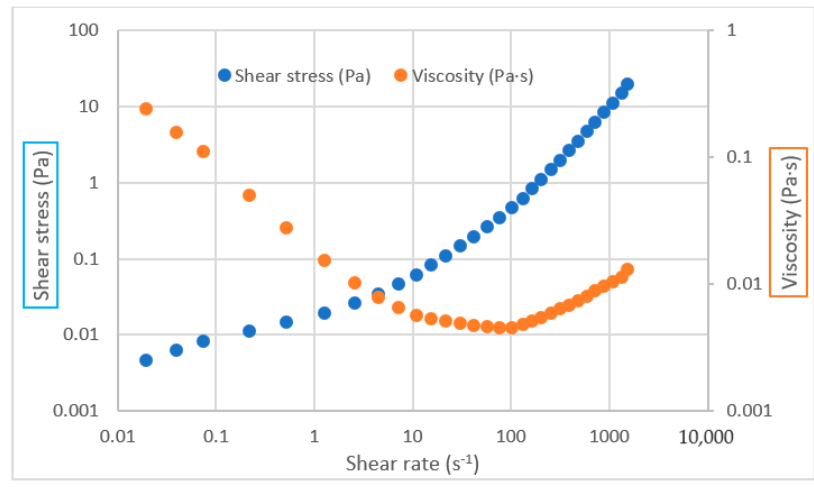
Figure 6. Rheological properties of the 10%—PVP K30/sterile water sample.